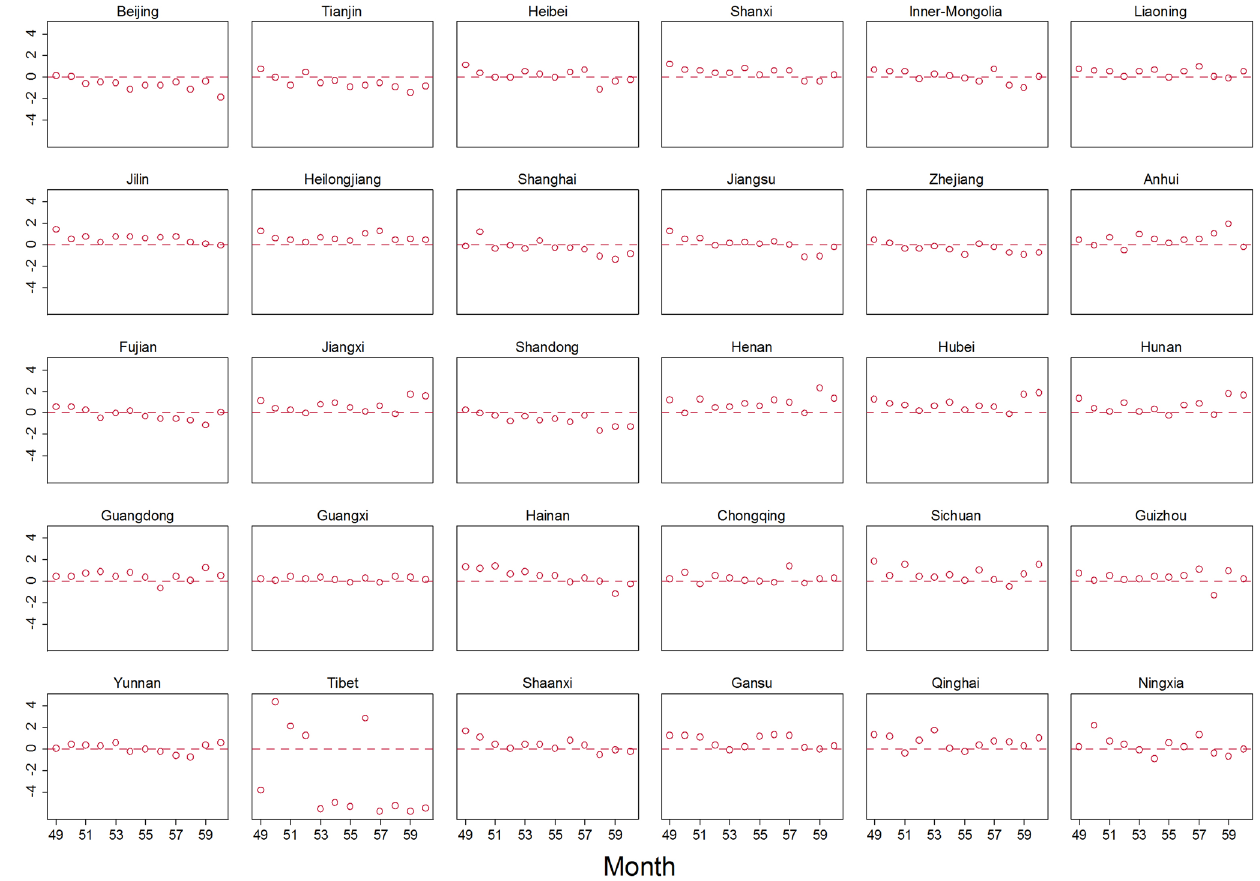
Figure 6. Forecasted error by